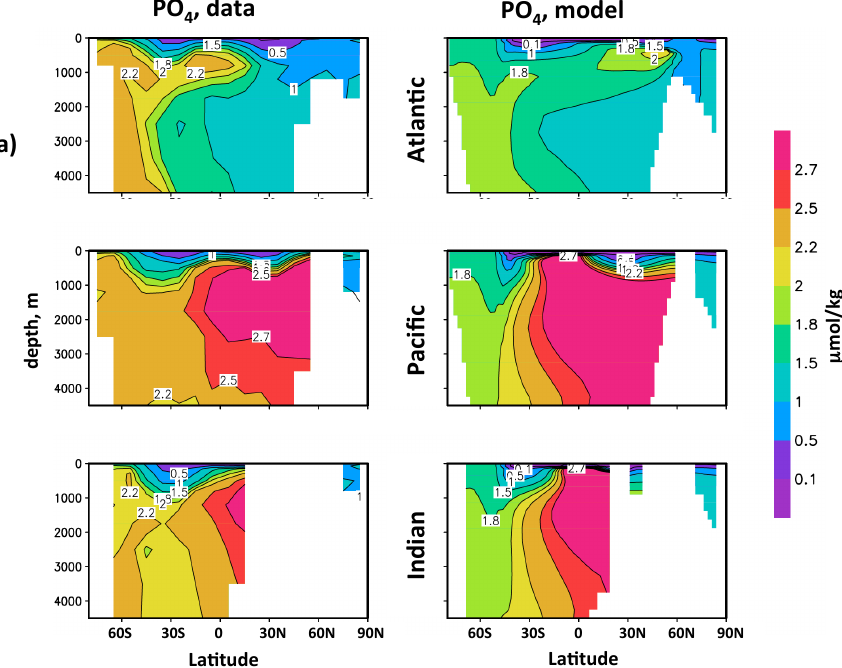
Fig. A1. Distribution of the biogeochemical tracers in the oceanic basins: (a) PO 4 , µmolkg − 1 ; (b) dissolved organic carbon (DIC), µmolkg − 1 ; (c) total alkalinity, (ALK), µeqkg − 1 ; (d) 14 C (‰). Left panel: GEOSECS data zonally averaged and interpolated onto the model grid; right panel: equilibrium model simulation for pre-industrial conditions.